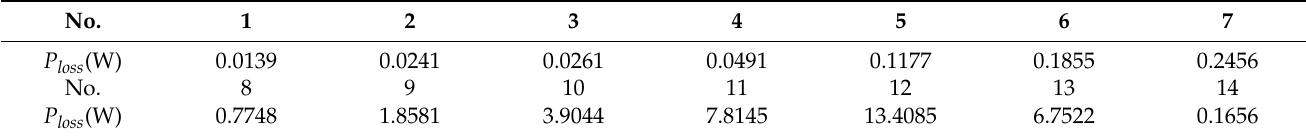
Table 4. Power loss for each section.